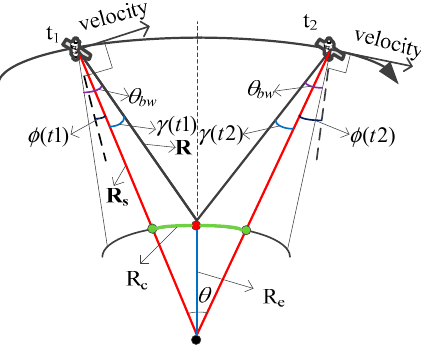
Figure 6. Geometric model of synthetic aperture time calculation.